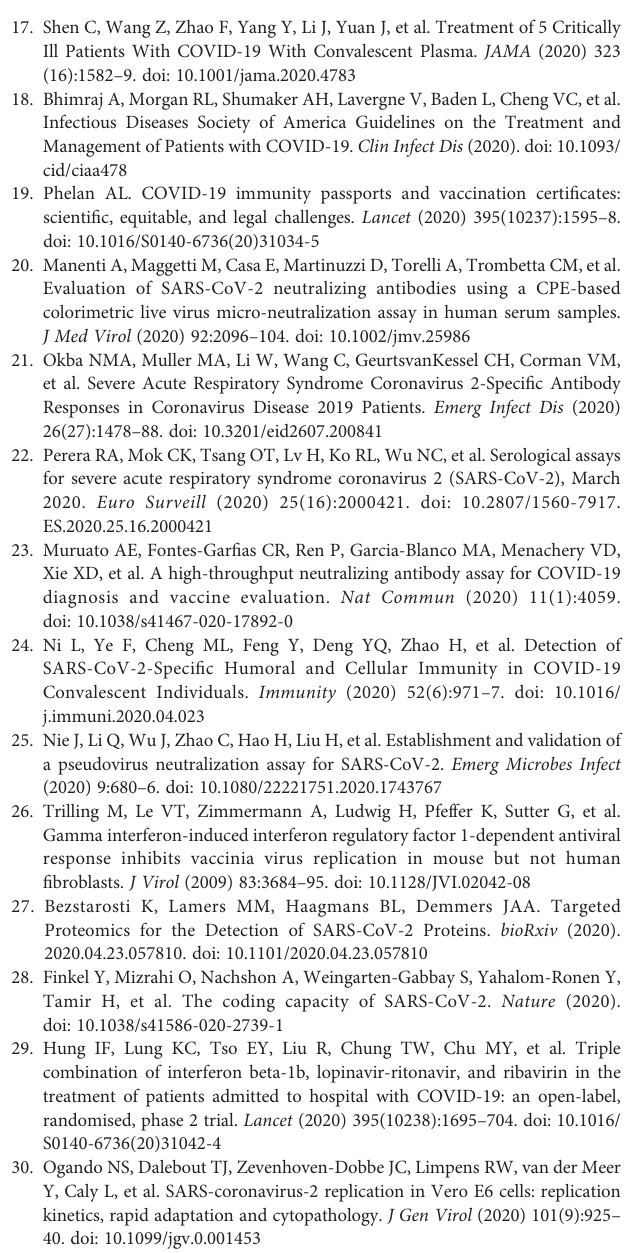
SUPPLEMENTARY FIGURE 1 | The infectious virus dose strongly in fl uences the neutralization capacity of serum samples. Graded amounts of SARS-CoV-2 were incubated with indicated dilutions of a serum sample (chosen to exhibit a low neutralizing capacity) for 1 h before Vero E6 cells were infected. Neutralization was evaluated by icELISA. SUPPLEMENTARY FIGURE 2 | The results of the high MOI icNT correlate with residual virus after neutralization. SARS-CoV-2 was incubated with indicated dilutions of serum samples for 1 h before Vero E6 cells were infected. (A) Neutralizing capacity was evaluated by icELISA. (B) Neutralizing capacity was evaluated by back titration of residual virus by TCID50 in 2-fold serial dilutions. SUPPLEMENTARY FILE 1 | Detailed SARS-CoV-2 icNT and icELISA laboratory